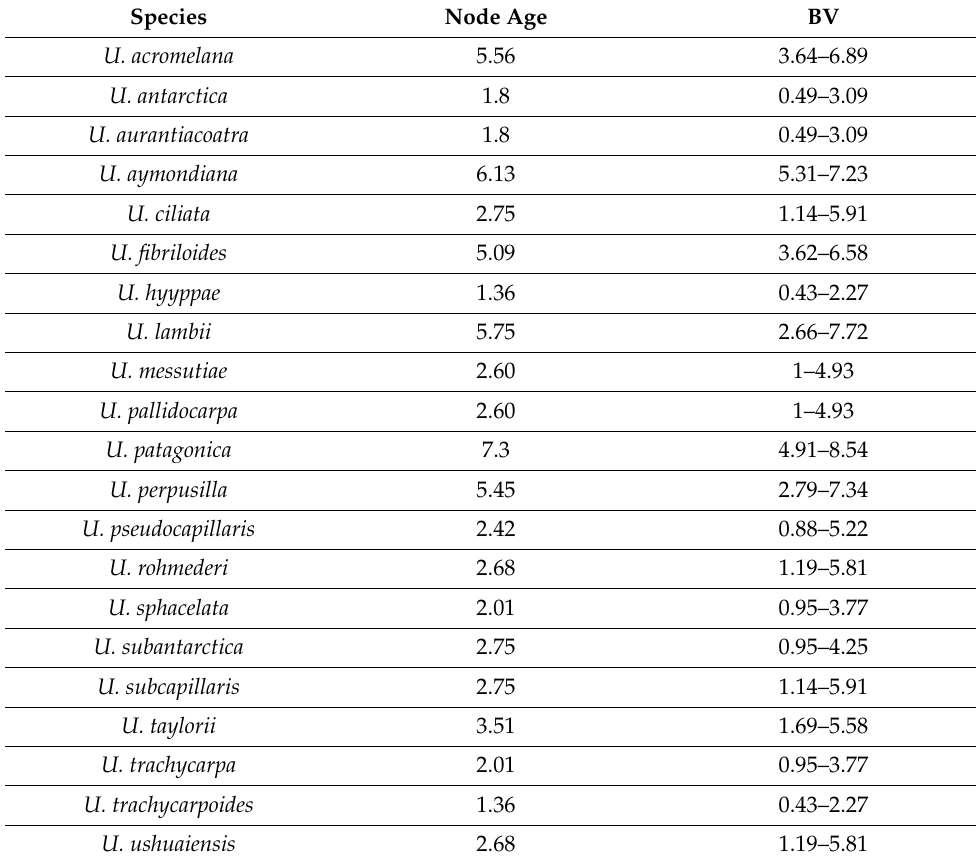
Table 3. Node ages (myr) and Bootstrapped variance (BV) intervals inferred through TreePL for Neuropogonoid